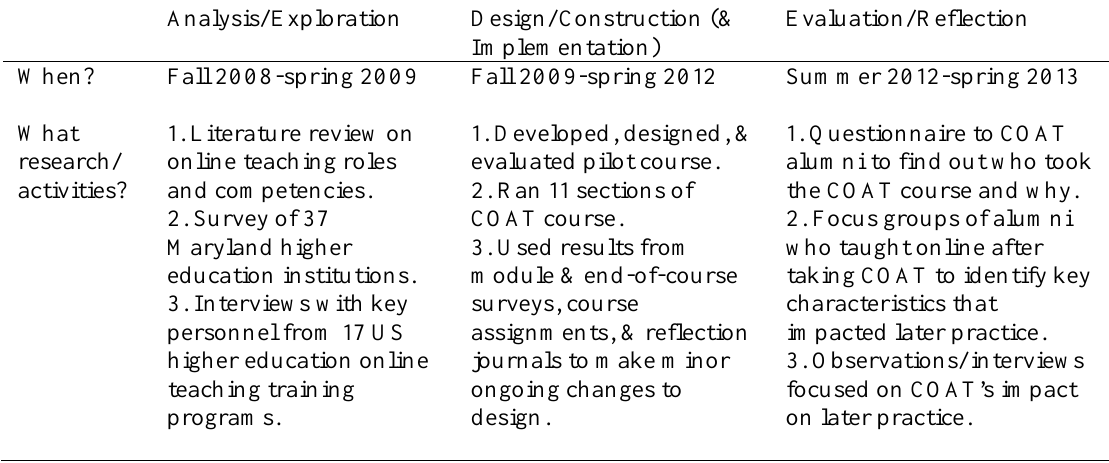
COAT Project and Generic Model for Design Research